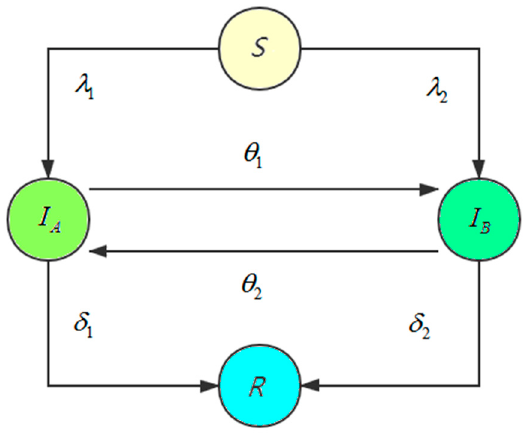
Figure 1. The state transition diagram.